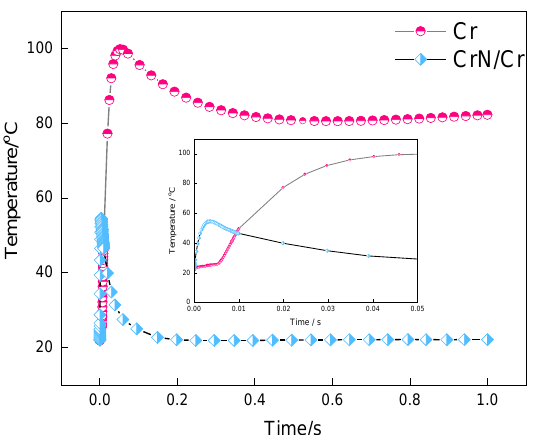
Figure 7. Variation curves of maximum temperature of bonding interface between Cr coating and CrN/Cr composite coating and gun steel matrix with gun firing time.